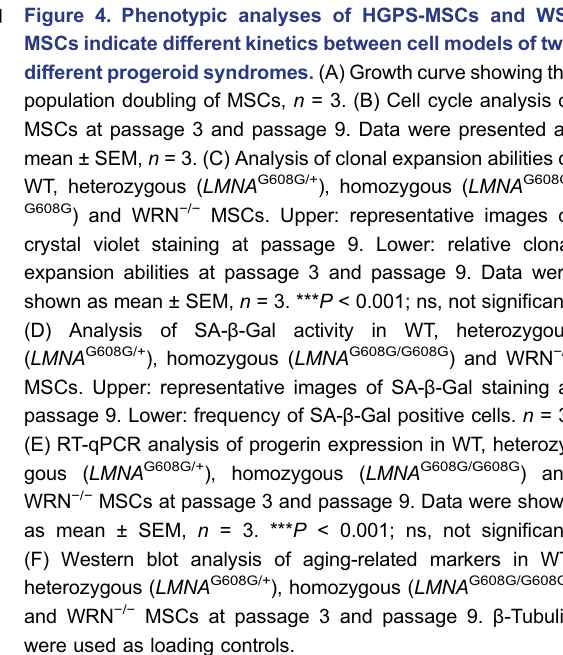
Figure 4. Phenotypic analyses of HGPS-MSCs and WS- MSCs indicate different kinetics between cell models of two different progeroid syndromes. (A) Growth curve showing the population doubling of MSCs, n = 3. (B) Cell cycle analysis of MSCs at passage 3 and passage 9. Data were presented as mean ± SEM, n = 3. (C) Analysis of clonal expansion abilities of WT, heterozygous ( LMNA G608G/+ ), homozygous ( LMNA G608G/ G608G ) and WRN − / − MSCs. Upper: representative images of crystal violet staining at passage 9. Lower: relative clonal expansion abilities at passage 3 and passage 9. Data were shown as mean ± SEM, n = 3. *** P < 0.001; ns, not signi fi cant. (D) Analysis of SA- β -Gal activity in WT, heterozygous ( LMNA G608G/+ ), homozygous ( LMNA G608G/G608G ) and WRN − / − MSCs. Upper: representative images of SA- β -Gal staining at passage 9. Lower: frequency of SA- β -Gal positive cells. n = 3. (E) RT-qPCR analysis of progerin expression in WT, heterozy- gous ( LMNA G608G/+ ), homozygous ( LMNA G608G/G608G ) and WRN − / − MSCs at passage 3 and passage 9. Data were shown as mean ± SEM, n = 3. *** P < 0.001; ns, not signi fi cant. (F) Western blot analysis of aging-related markers in WT, heterozygous ( LMNA G608G/+ ), homozygous ( LMNA G608G/G608G ) and WRN − / − MSCs at passage 3 and passage 9. β -Tubulin were used as loading